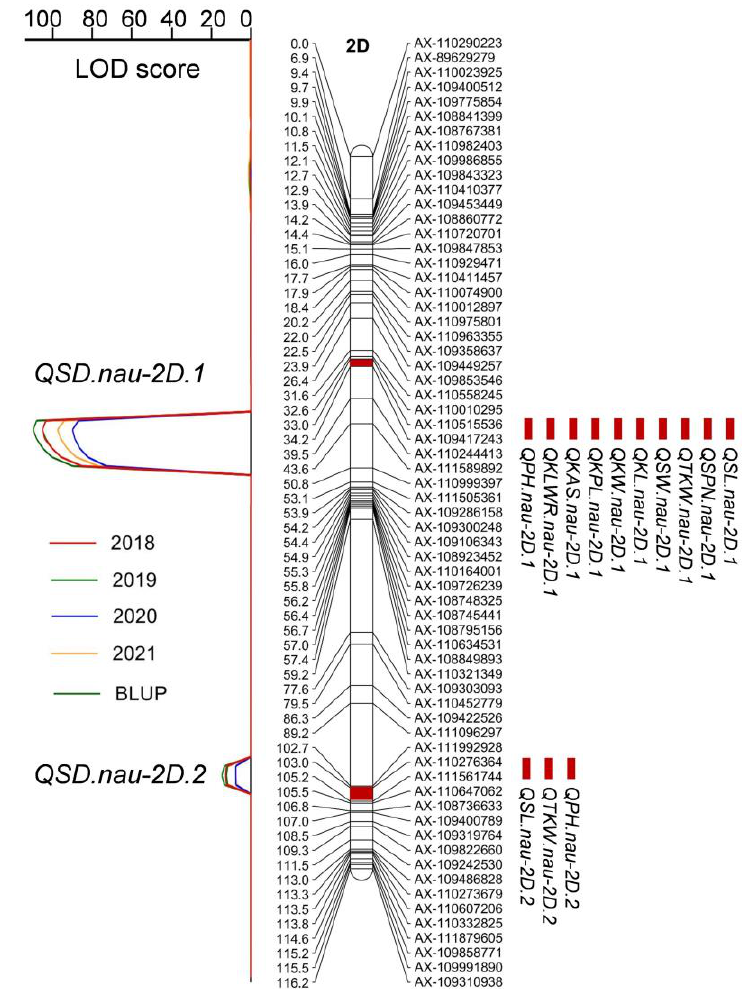
Figure 3. QTL mapping of the morphological traits on chromosome 2D. Middle: a linkage map of chromosome 2D. Genetic distances are represented in centimorgans on the left and SNP markers were on the right of chromosome 2D. Left: QTL likelihood curves of LOD scores (>3.0) based on spikelet density (SD) from four environments during years 2018 – 2021 and their BLUP values. Right: chromosomal positions of identified QTL for the plant height, grain and spike-related traits on chromosome 2D mapped to the same regions with QSD.nau-2D.1 and QSD.nau-2D.2 . BLUP is based on the values from four years’ environmental trials (2018–2021). Abbreviations: PH, plant height; TN, tiller number; SL, spike length; SD, spikelet density; SW, spike weight; SPN, total spikelet number per spike; FSPN, fertile spikelet number per spike; SSPN, basal sterile spikelet number per spike; KNS, number of kernels per spike; KL, kernel length; KW, kernel width; KLWR, kernel length-to-width ratio; TKW, thousand kernel weight; KAS, kernel area size; KPL, kernel perimeter